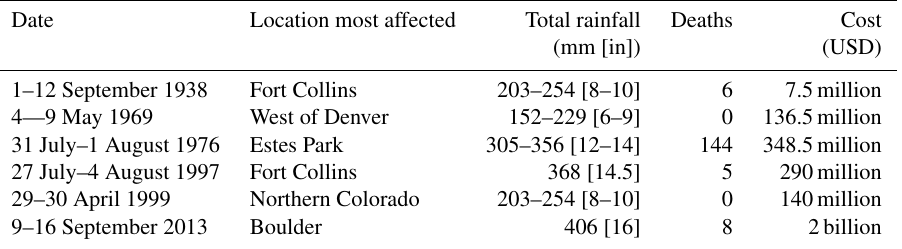
Table 1. A comparison of the September 2013 event to previous heavy, flood-inducing precipitation events in northern Colorado history. All monetary values were calibrated to 2013